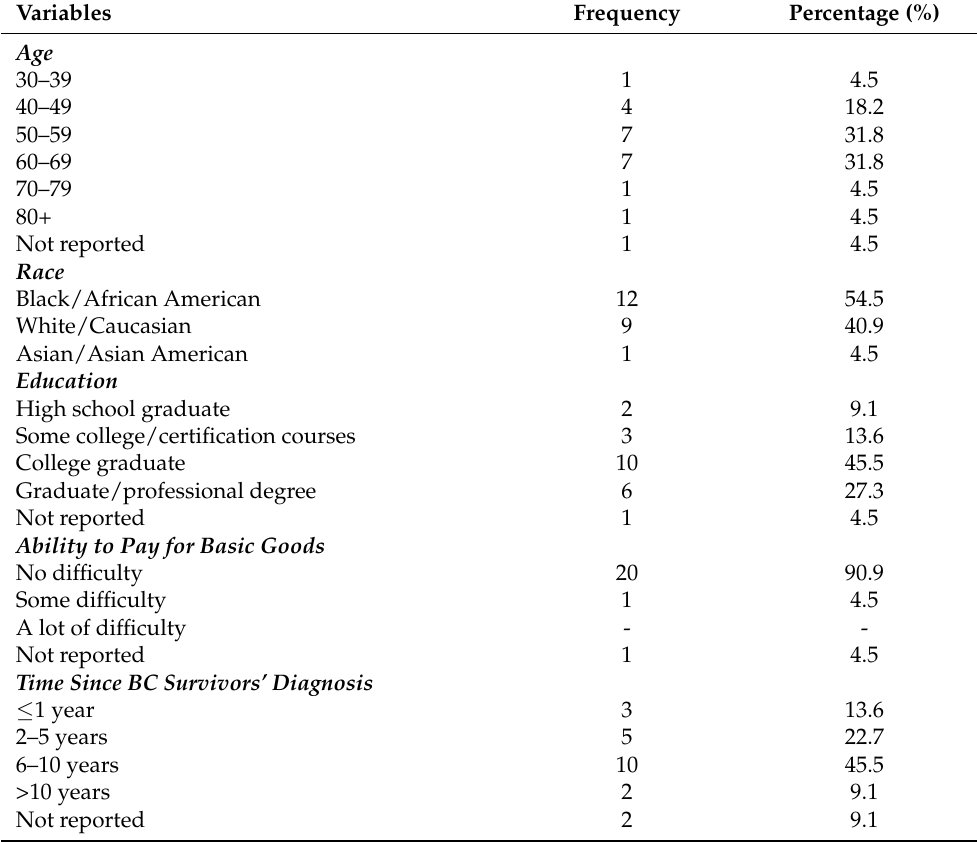
Table 1. Demographic characteristics of the participants ( n =